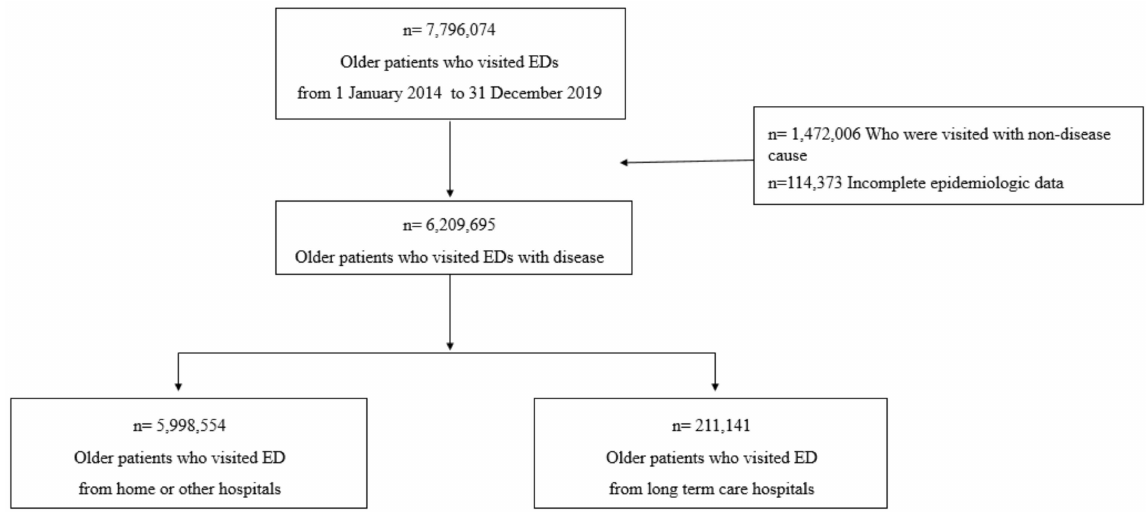
Figure 1. Flowgram of